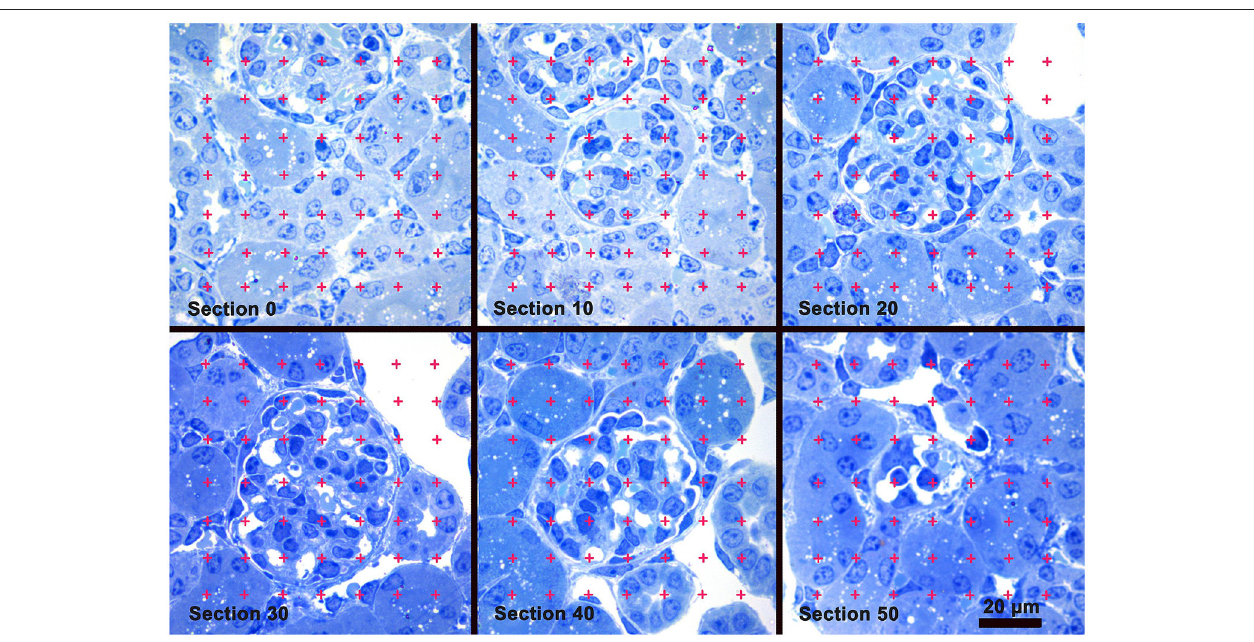
FIGURE 1 | Glomerular Volume by the Cavalieri Principle. A sample of images from a stack of sections used to measure glomerular volume. Section 0 precedes the appearance of the glomerulus present in sections 10 thru 50. A counting grid was randomly placed over each glomerular profile and the number of grid points falling on the profiles was counted. Glomerular volume was calculated by multiplying the distance between the sections by the sum of the points falling on all the profiles from the glomerulus, and then multiplied by the area represented by one grid point. Toluidine blue stain.